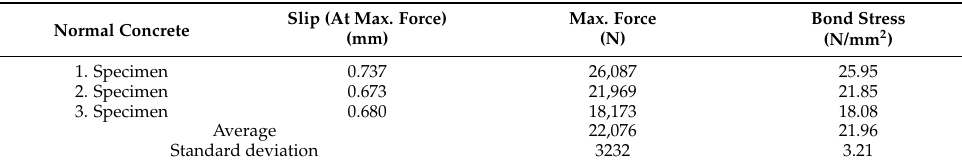
Table 6. Bond stress of NWAC.